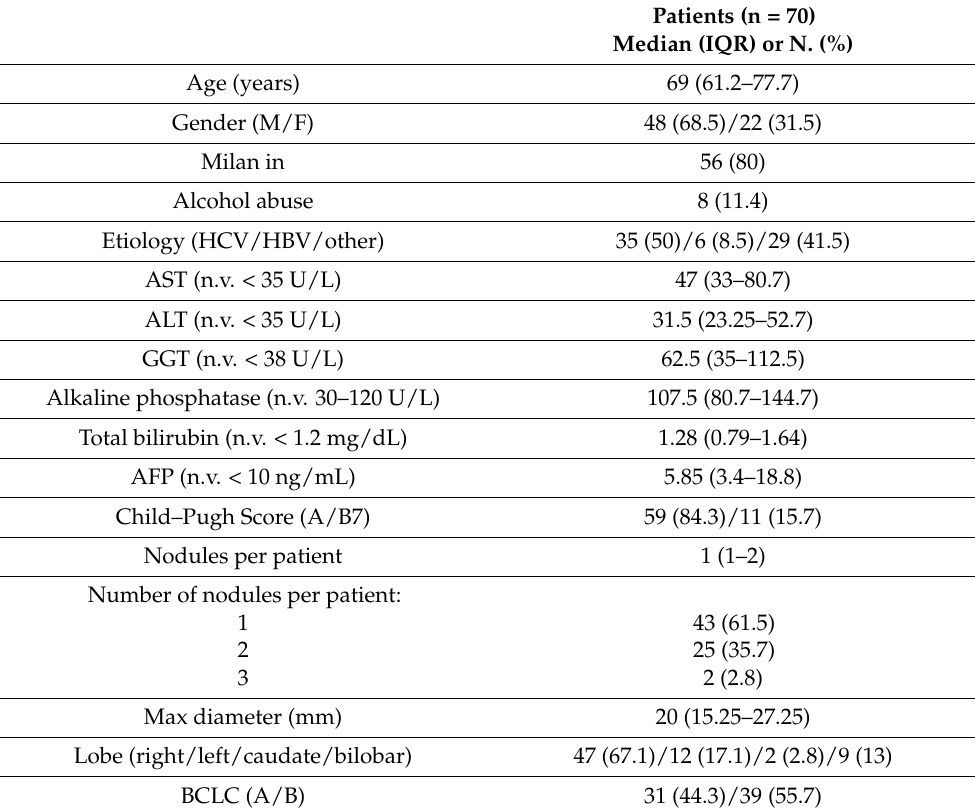
Table 1. Demographical characteristics and tumor burden of the study population at